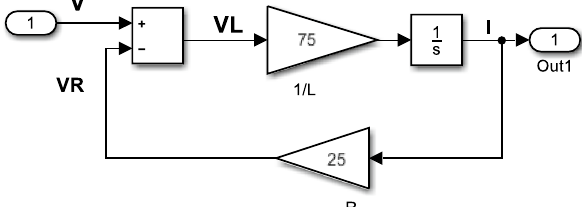
Fig. 5 Frequency-Power Measurement Module